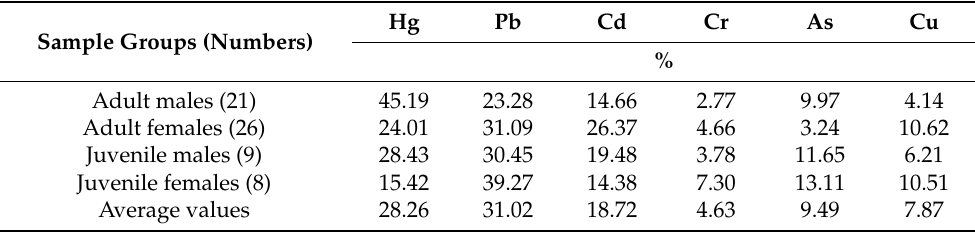
Table 6. The cumulative contribution rate of toxic trace elements in human hair from different groups in the polluted